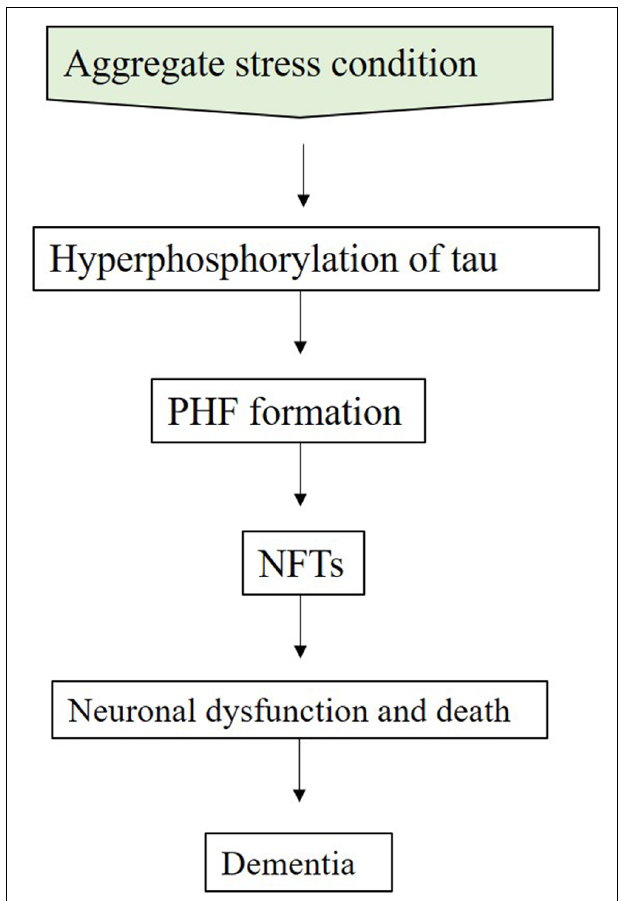
FIGURE 3 | Schematic of tau hypothesis. Aggregate stress condition is a condition in which A β aggregation alters the kinase/phosphatase activity that can lead to hyperphosphorylation of tau resulting in PHF formation which consequently leads to neuronal dysfunction and dementia (Verwilst et al., 2018). Abbreviations: PHF, paired helical filament; NFT, neurofibrillary